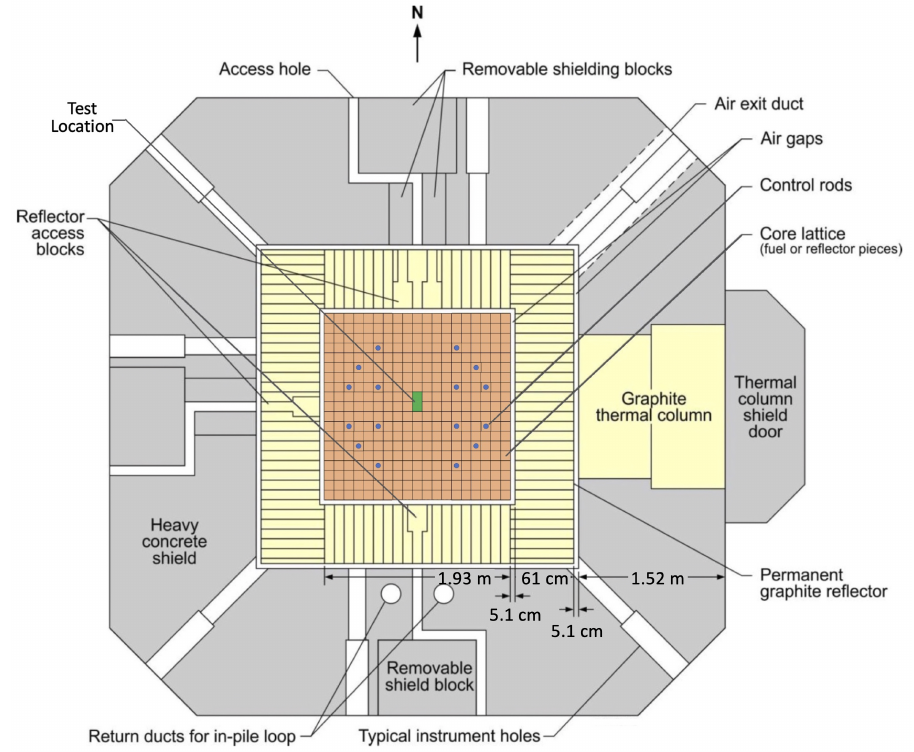
Figure 1. Top view of the TREAT core, permanent reflector and biological shielding